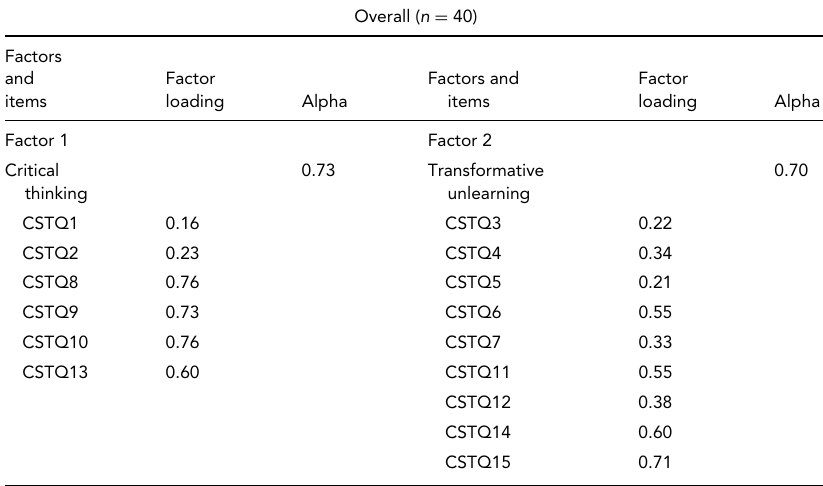
Exploratory Factor Analysis and Internal Consistency of